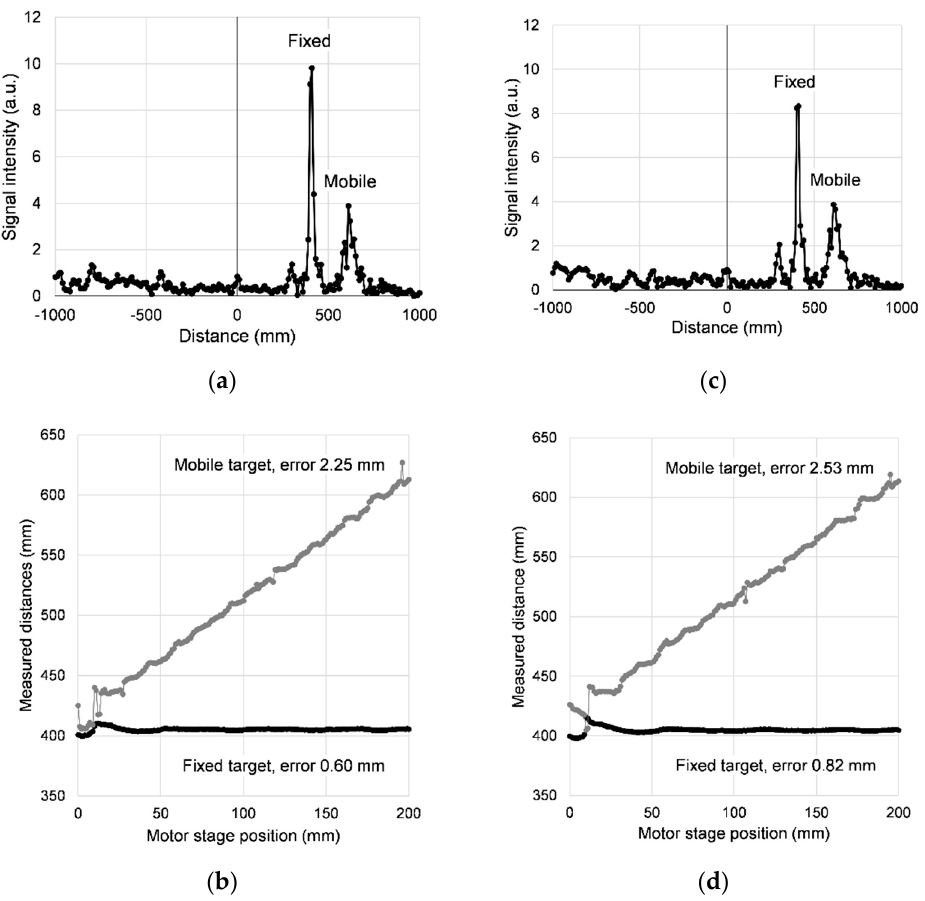
Figure 5. Measurement results on two targets, a fixed half mirror and a mobile full mirror; the modulation frequency had 512 values from 3 to 18 GHz. ( a ) The Fourier transform when the mobile target is in its most distant position from the fixed target, with the motor stage at 200 mm. ( b ) The distance to the two targets as measured by the DFT radar; the ranging errors included in the labels exclude the first 20 mm part of the motor stage position, where the two peaks are not clearly resolved. ( c , d ) The corresponding data for the case where a layer of cotton fabric was inserted in the beam on each side of the half mirror. The measurement errors are slightly